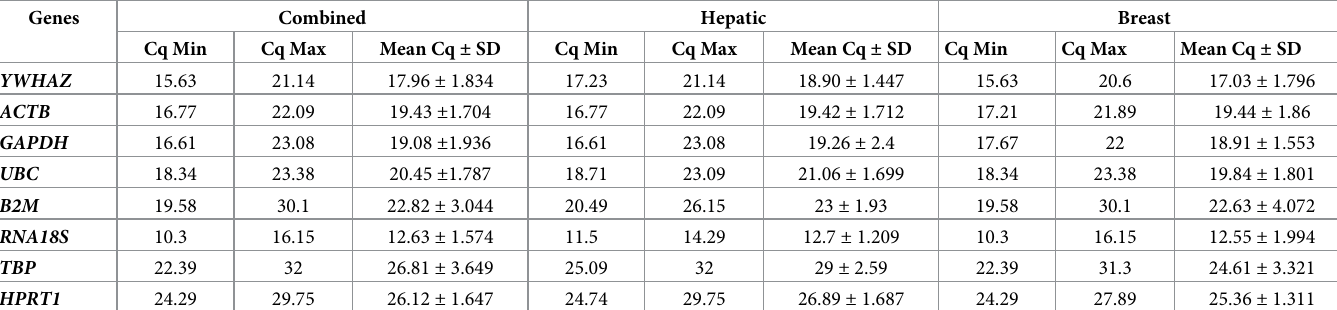
The Mean Cq ± SD values in the combined column refer to the statistical analysis of samples of six cancer cell lines and their biological replicates (n = 12). Accordingly, the hepatic column and breast column contain Mean Cq values derived from samples of three hepatic cancer cell lines (including two biological replicates for each cell line, n = 6) and three breast cancer cell lines (including two biological replicates for each cell line, n = 6), respectively. The Cq Min and Cq Max values in hepatic and breast columns represent the lowest and the highest Cq values across samples of three different hepatic or three different breast cancer cell lines and their biological replicates, respectively. Each of these Cq Min or Cq Max values is itself the mean of technical triplicates.